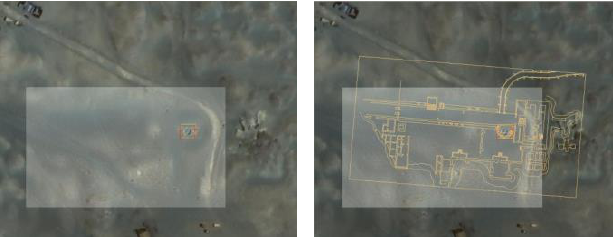
Figure 7. Detection of Archaeological Sites within the End-user GIS System: Serapeum test case. Quckbird data res 1 m (the researched shape is shown on the left).